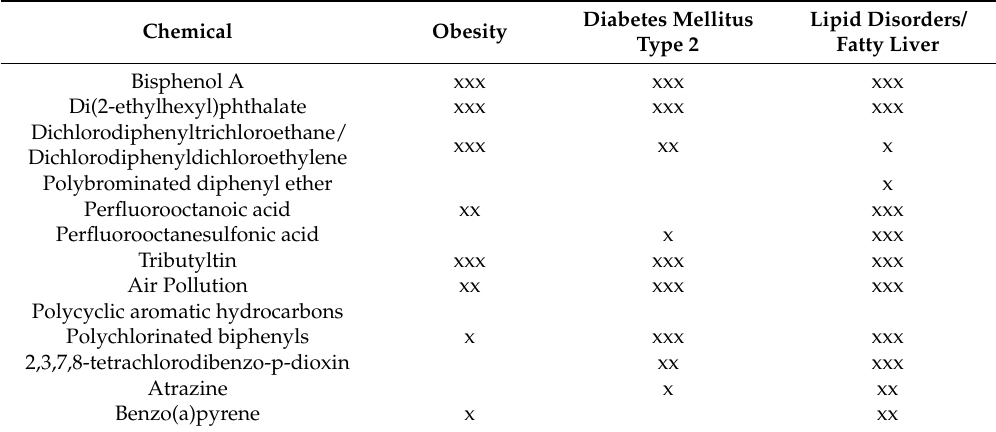
Table 2. Obesity, diabetes mellitus type 2 and lipid disorders induced by endocrine disruptors are involved in metabolic syndrome with a small (x), medium (xx) and large (xxx) qualitative correlation (modified from